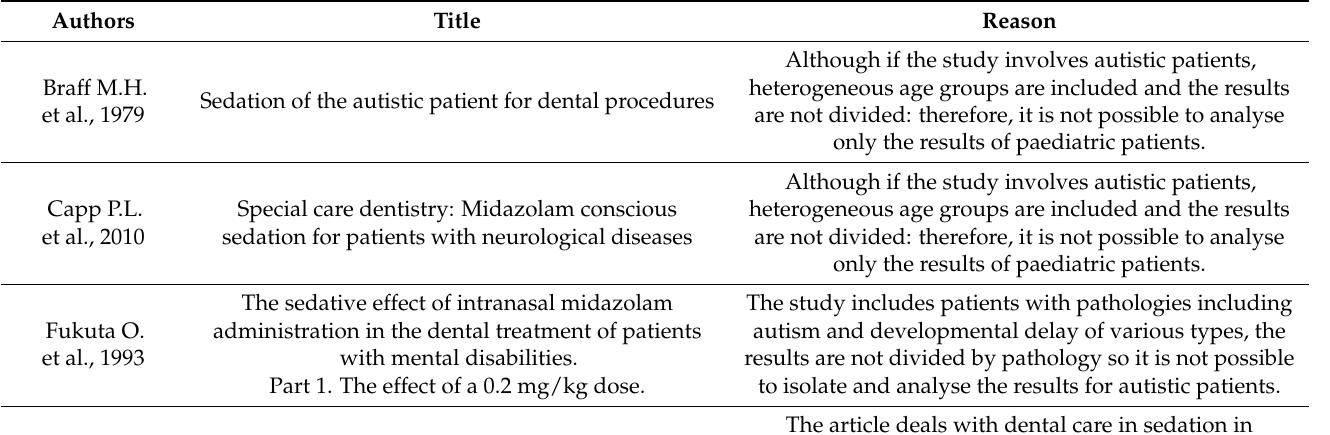
Table 1. Reasons for excluding 17 studies